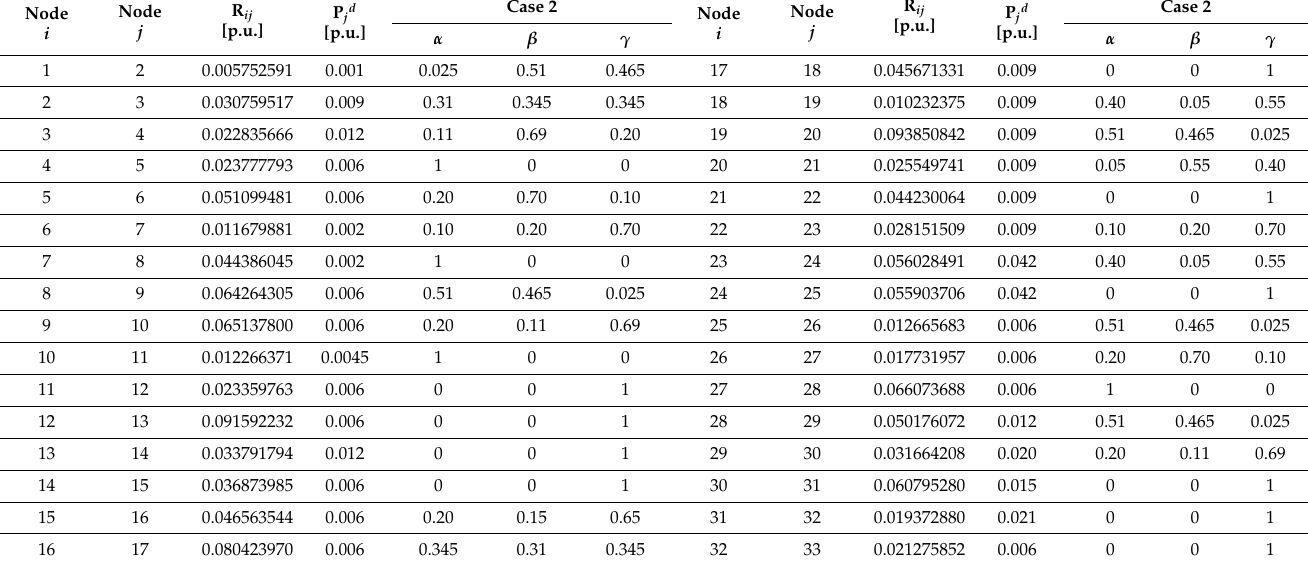
Table A1. Parameters of the 33-node test feeder.